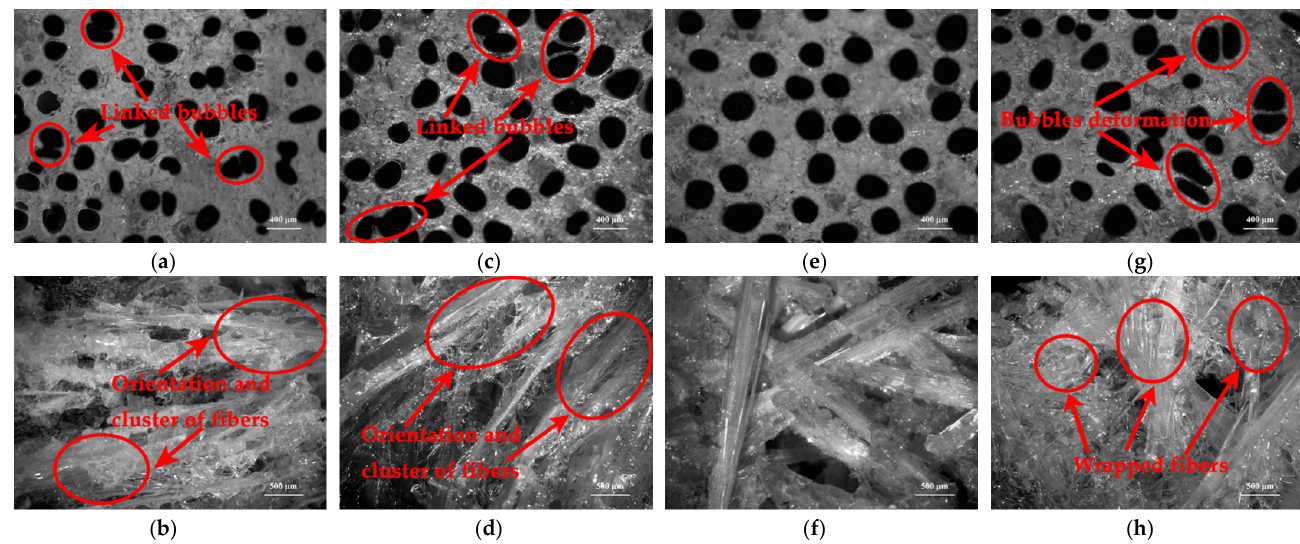
Figure 9. Micrographs of cured samples with the presence of 20.00 phr long chopped glass fiber and the coexistence of MEKP-II and cobalt naphthenate: ( a , b ) cured CGFR-LDUPR composite sample in the presence of 3.0 mm chopped glass fiber, ( c , d ) cured CGFR-LDUPR composite sample in the presence of 9.0 mm chopped glass fiber, ( e , f ) cured LCGFR-LDUPR composite sample in the presence of 15.0 mm chopped glass fiber, ( g , h ) cured LCGFR-LDUPR composite sample in the presence of 21.0 mm chopped glass fiber.